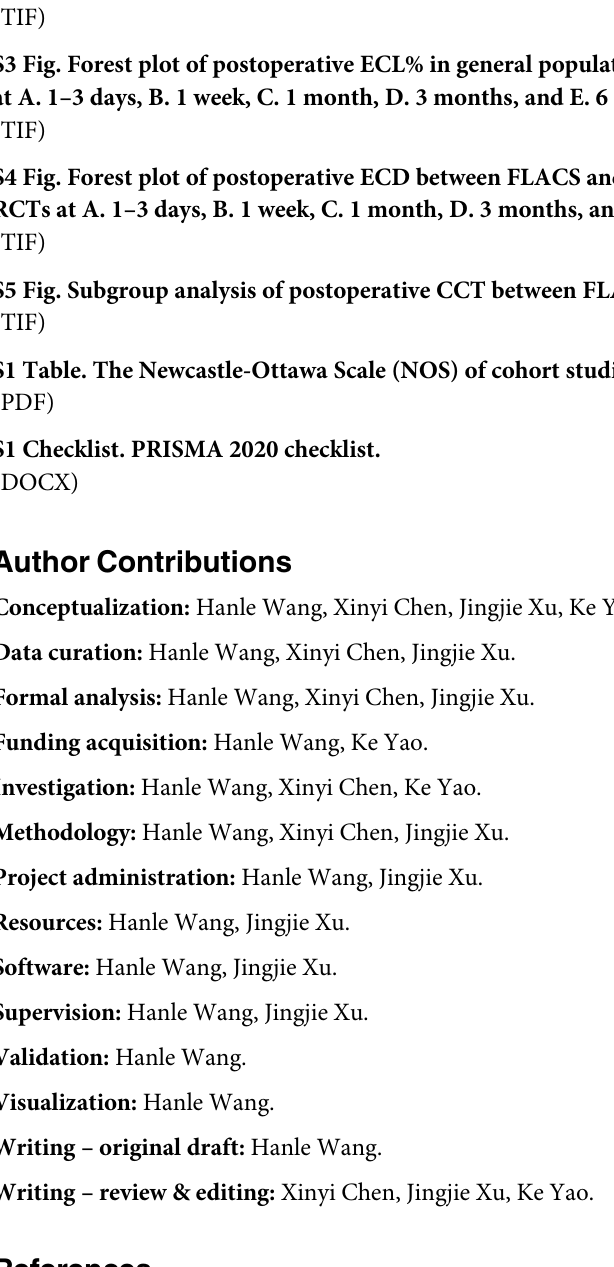
S2 Fig. Assessment of the risk of bias in the included RCTs. Green circle (+): Low risk, Red circle ( − ): High risk,?: Unclear. (TIF) S3 Fig. Forest plot of postoperative ECL% in general population between FLACS and CPS (TIF) S4 Fig. Forest plot of postoperative ECD between FLACS and CPS that only included (TIF) S5 Fig. Subgroup analysis of postoperative CCT between FLACS and CPS at 1–3 days. (TIF) S1 Table. The Newcastle-Ottawa Scale (NOS) of cohort studies.